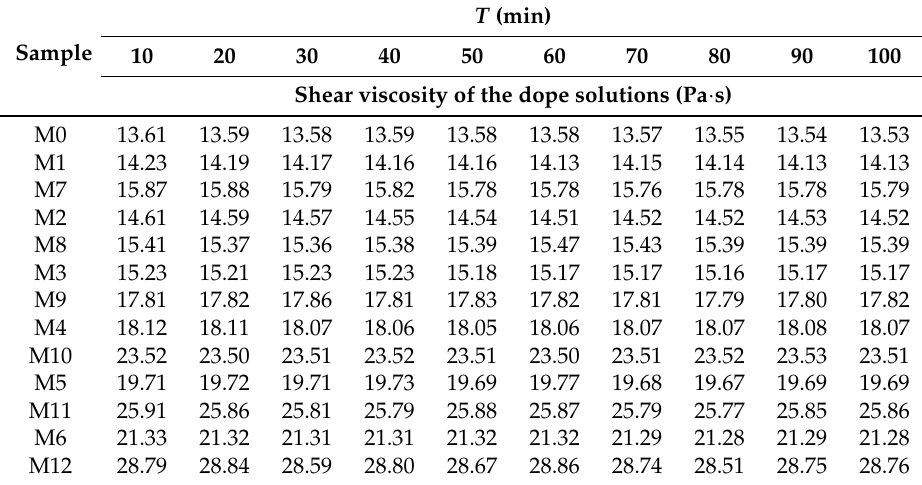
Table 3. Shear viscosity of membrane solutions.